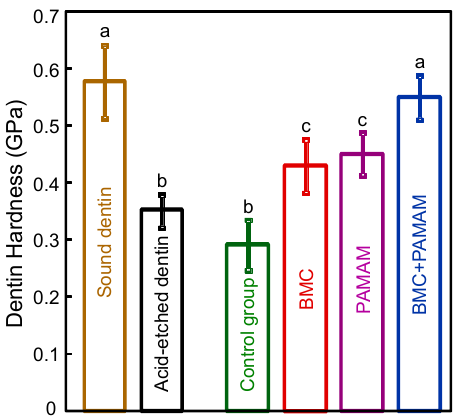
Figure 4. Hardness of root dentin. Healthy untreated root dentin and acid-etched root dentin were included for comparison. Four groups were measured after 21 days of artificial saliva/lactic acid regimen treatment: Control, BMC group, PAMAM group, and BMC + PAMAM group. Dissimilar letters indicate significantly different values ( p = 0.022).